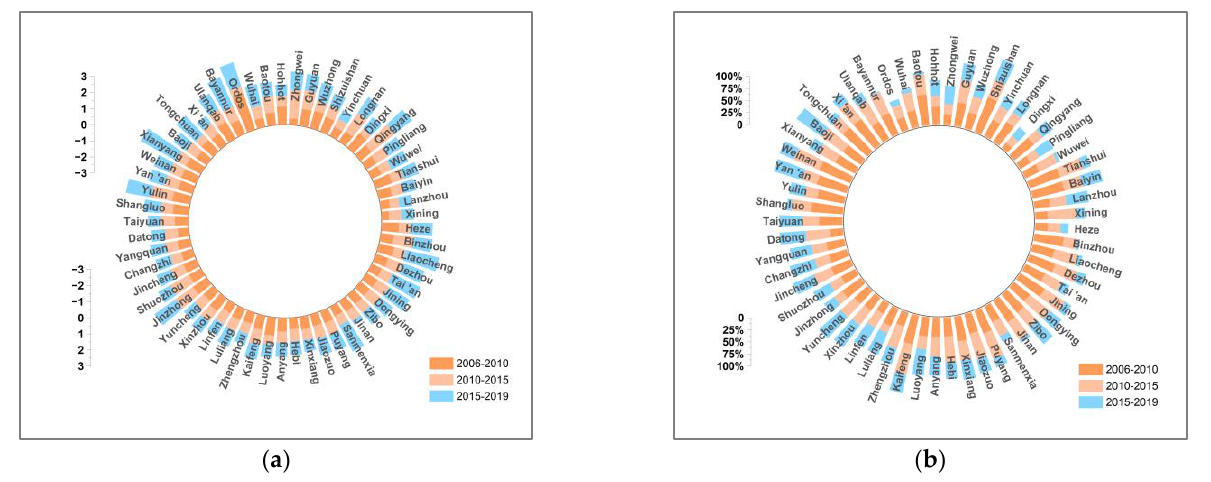
Figure 8. Contribution and contribution rate of economic-output factor. ( a ) Contribution of economic-output factor. ( b ) Contribution rate of economic-output factor.